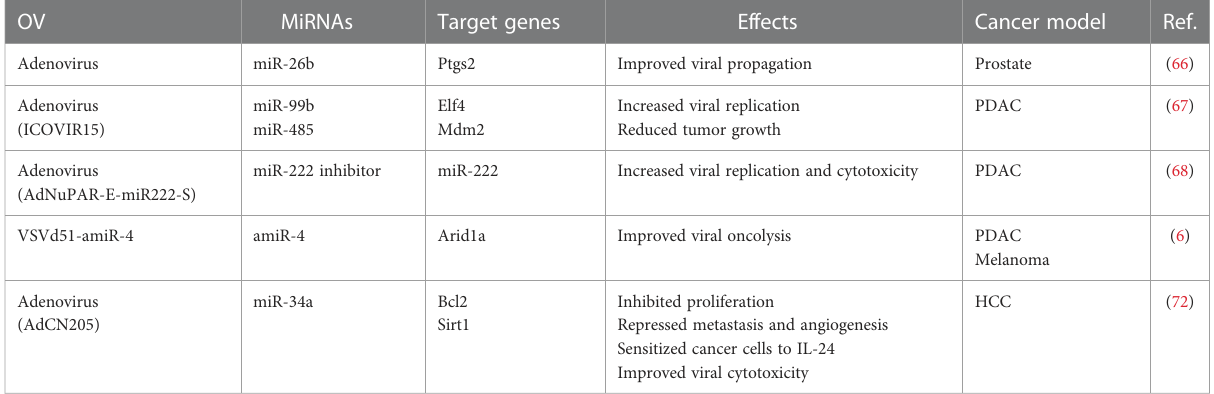
TABLE 2 Summary of OVs expressing miRNAs and their mechanisms of action.